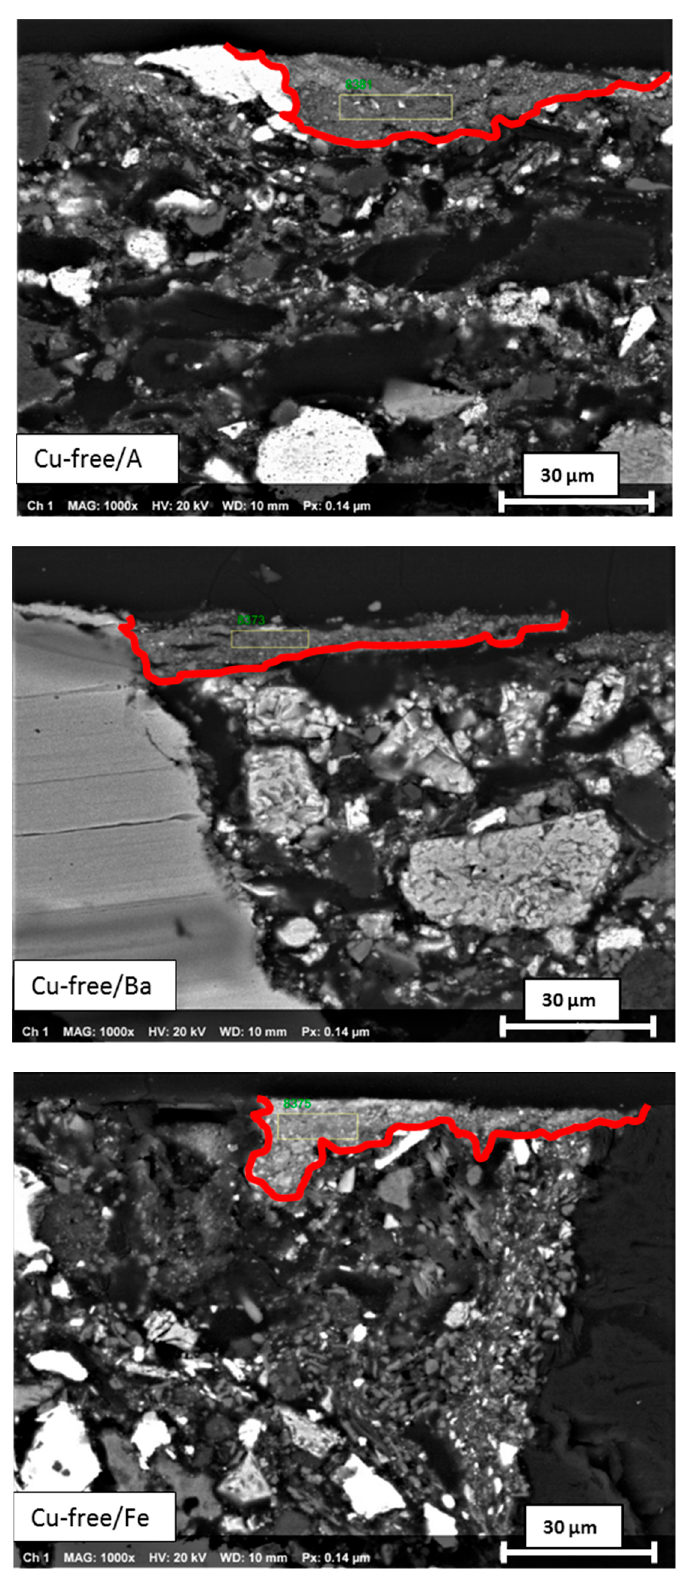
Figure 7. SEM observations of the pins’ cross section. Secondary plateau is highlighted in red.